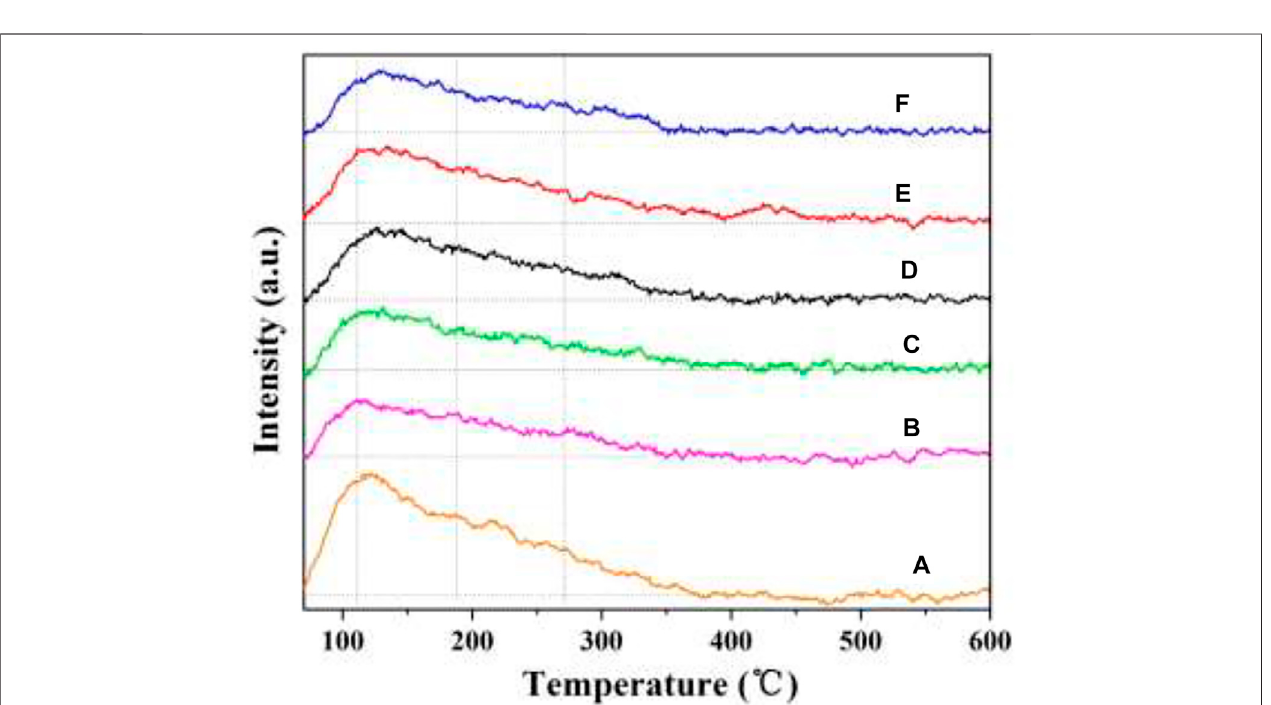
FIGURE 10 | NH 3 -TPD pro fi les of the 3DOM catalysts. (A) W 1 CeO δ /ZrTiO 4 ; (B) W 1 MnO δ /ZrTiO 4 ; (C) W 1 CeMnO δ /TiO 2 ; (D) W 0.5 CeMnO δ /ZrTiO 4 ; (E) W 1 CeMnO δ / ZrTiO 4 ; (F) W 2 CeMnO δ /ZrTiO 4